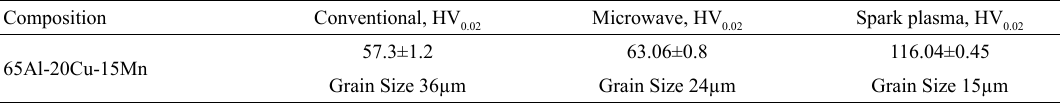
Table 1. Micro-Hardness and Grain sizevalues of sintered samples Composition